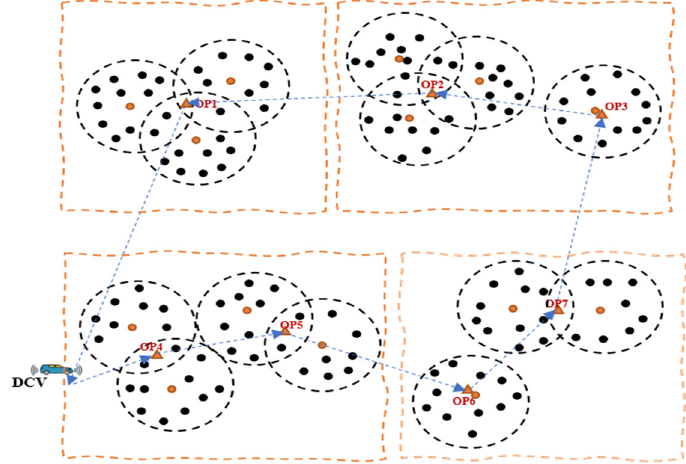
Figure 5. Optimal point selection and path computation with a single DCV.